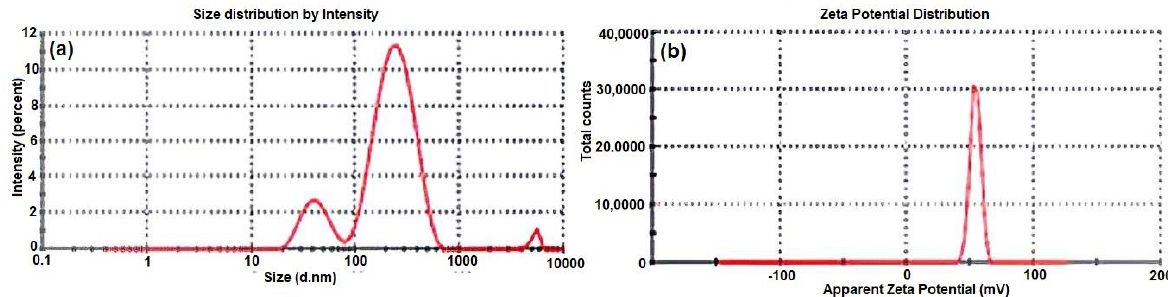
like CS, as claimed by Senthilvel et al. (2022) [31].